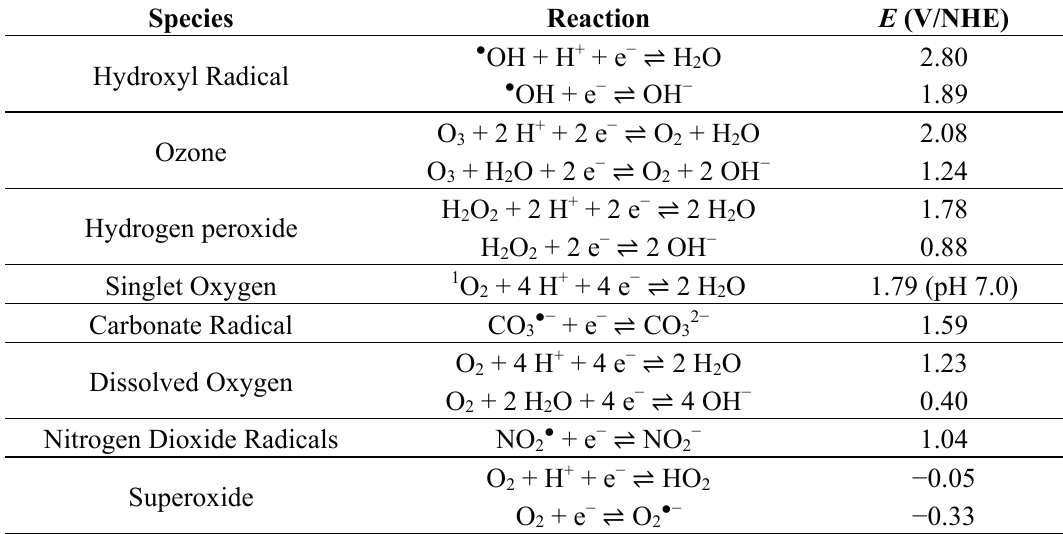
Table 3. Redox potentials for some reactive oxygen species (ROS) and reactive nitrogen species (RNS) (Data taken from